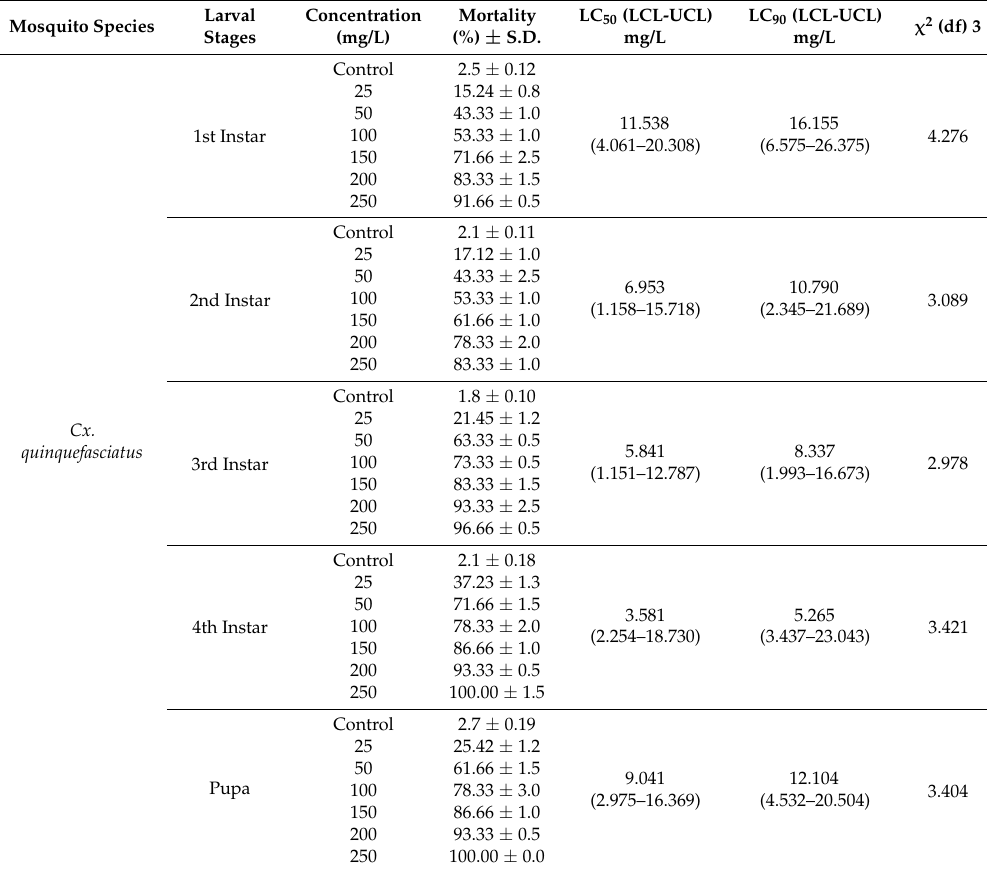
Table 1. Larvicidal and pupicidal activity of B. bassiana -28 fungal mycelium extract (ethyl acetate) against larvae and pupa of Cx. quinquefasciatus (after 24 h of exposure). Larval Concentration Mortality Mosquito Species Stages (mg/L) (%) ±